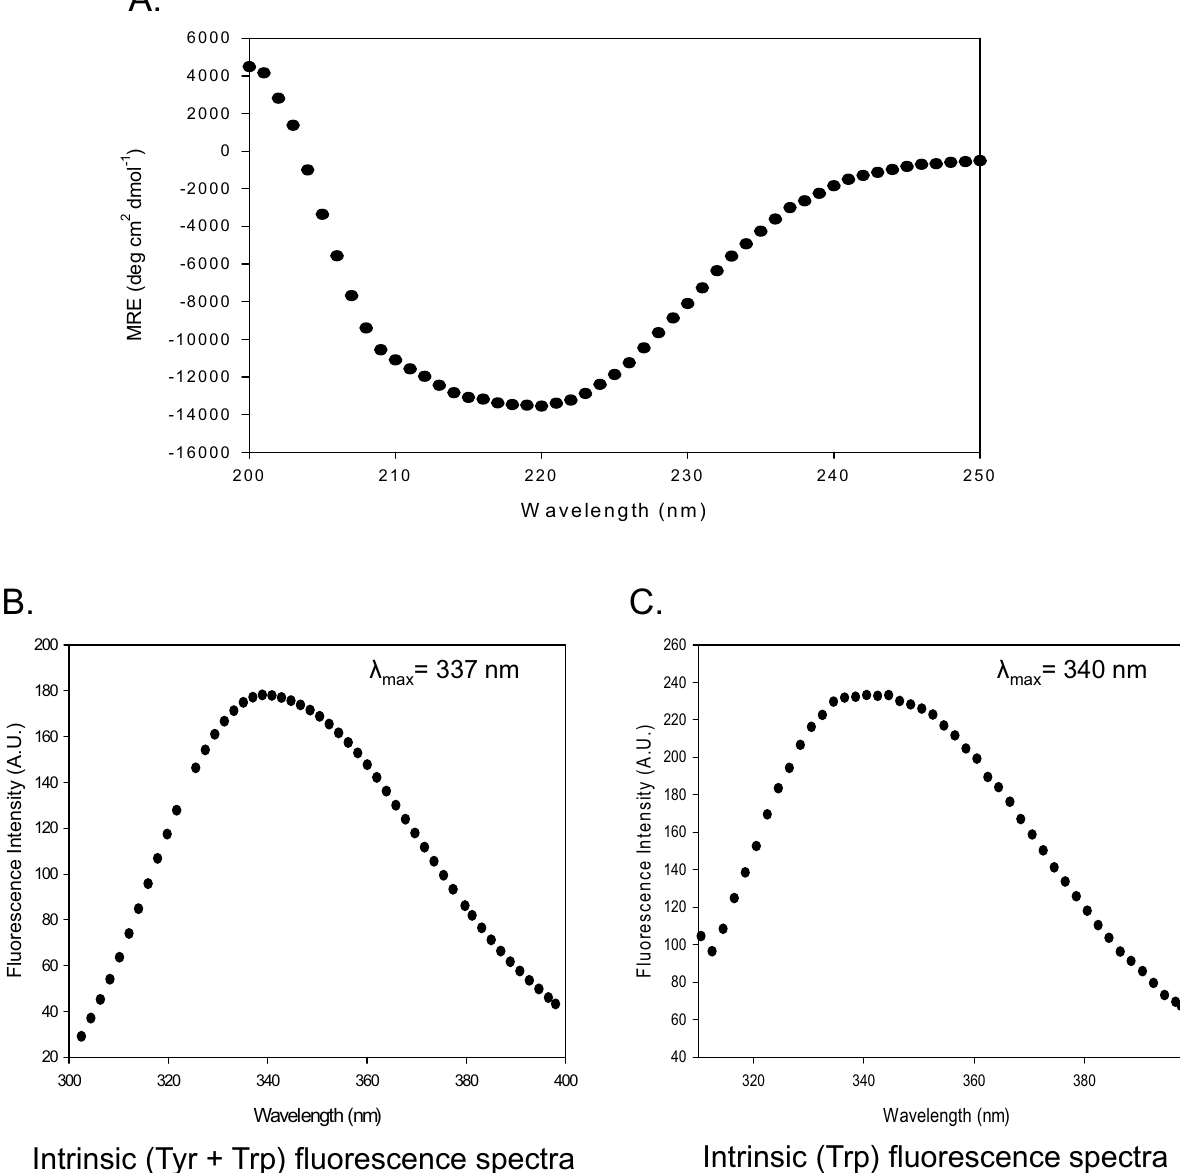
Figure 5. Secondary and tertiary structure determination of AAR. ( A ) Graph shows Far-UV CD spectra of AAR (3.5 µM) monitored from 250 to 200 nm wavelength to determine secondary structure. Tertiary structure determination of AAR probed by intrinsic fluorescence spectroscopy was performed by ( B ) Intrinsic (Trp + Tyr) emission fluorescence spectra of AAR (3.5 µM) with excitation at 280 nm, and ( C ) intrinsic (Trp) emission fluorescence spectra of AAR with excitation at 295